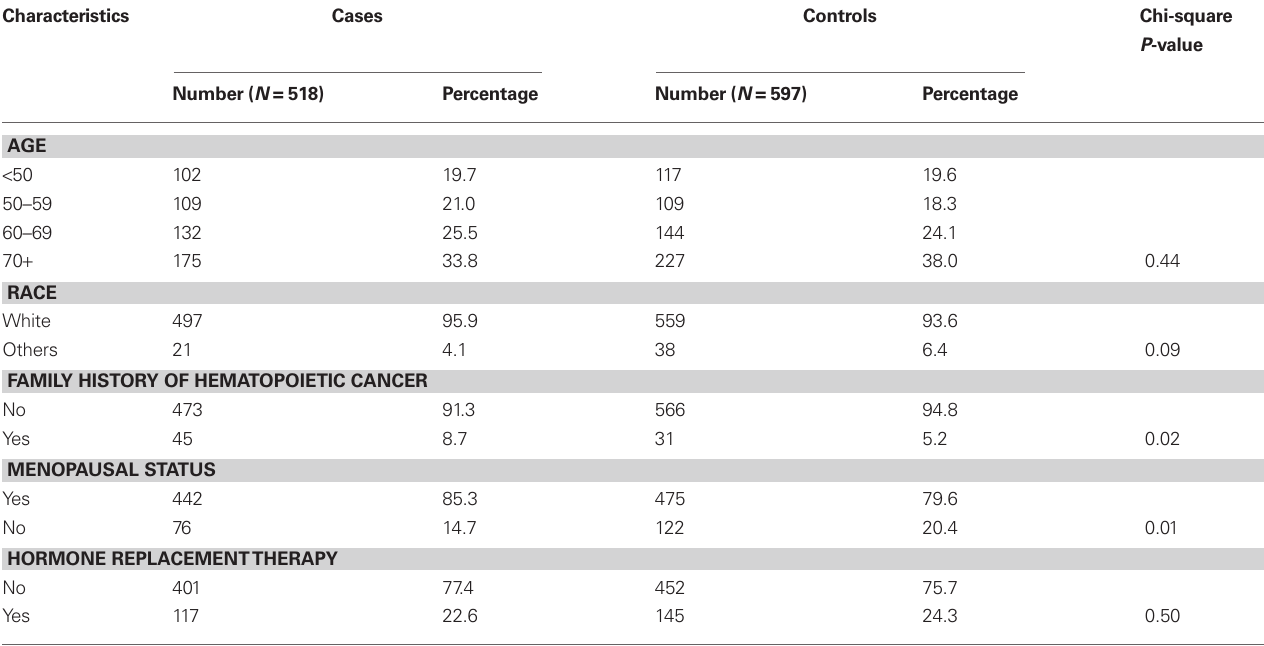
Table 1 | Distributions of selected characteristics of study population.